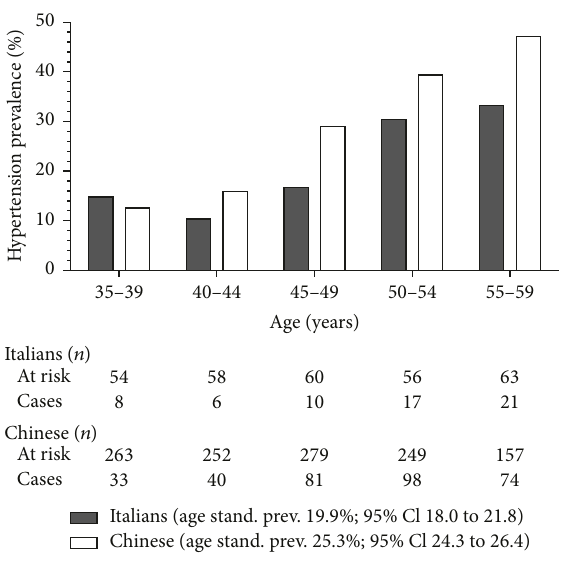
Figure 1: Age specific and age standardized (to WHO population 2001)prevalenceofhypertensionintheCHIPstudypopulationaged 35 to 59 years.